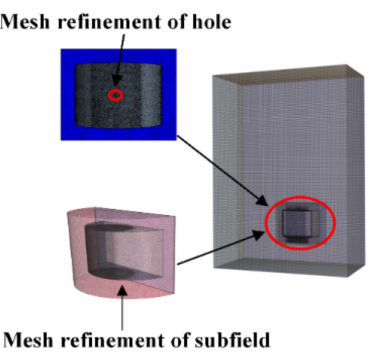
Figure 3. Boundary conditions.